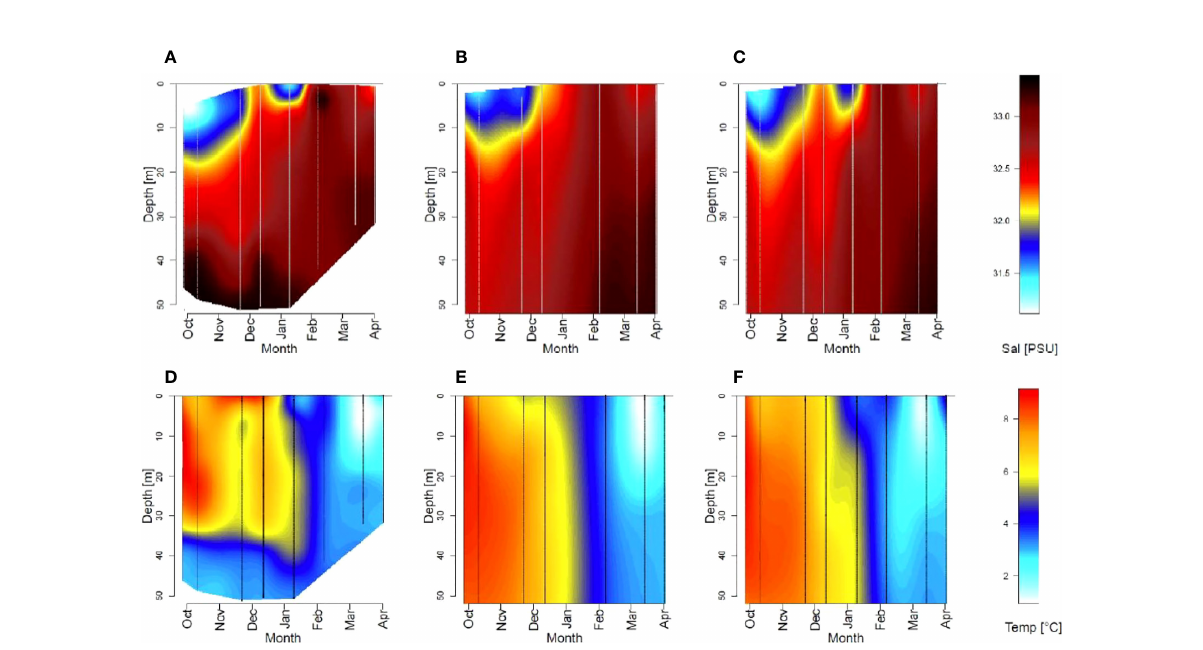
FIGURE 3 Seasonal changes of salinity (> 31 PSU, A – C ) and temperature (D – F) in Ramfjorden for stations 1 (A, D) , 2 (B, E) and 3 (C, F) for the upper 50m of the water column. Vertical lines indicate the time and depth of measurements.